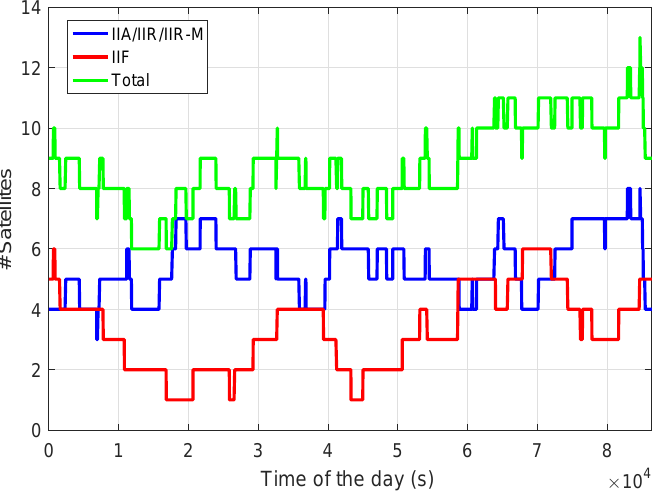
Figure 1. Number of visible GPS satellites for station CUAA in Perth, Australia, on DOY 240,